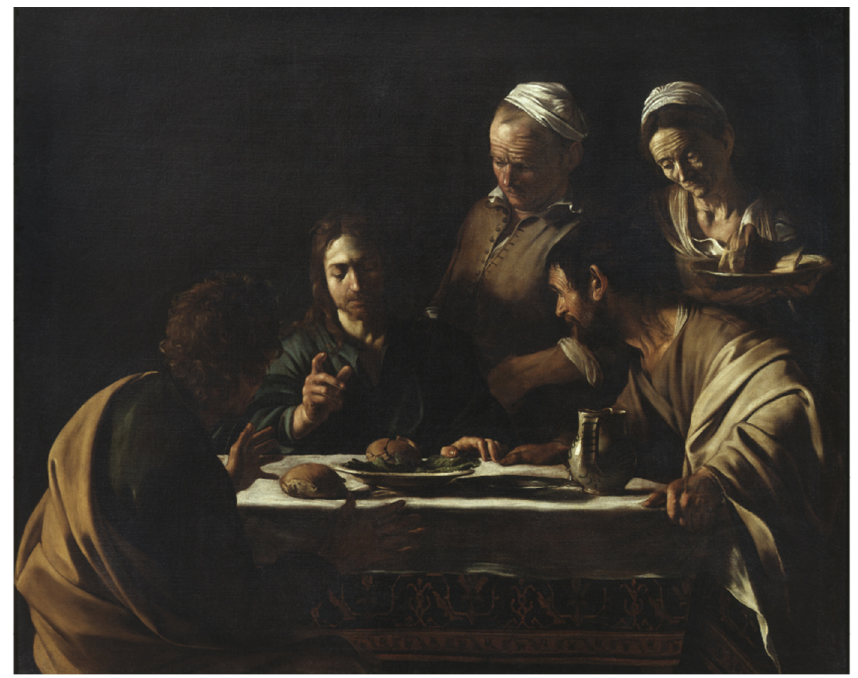
Figure 9. Caravaggio’s Supper at Emmaus of (Caravaggio 1606). The Pinacoteca di Brera online, https://pinacotecabrera.org/en/collezione-online/opere/supper-at-emmaus/, (accessed on 31 May 2022).